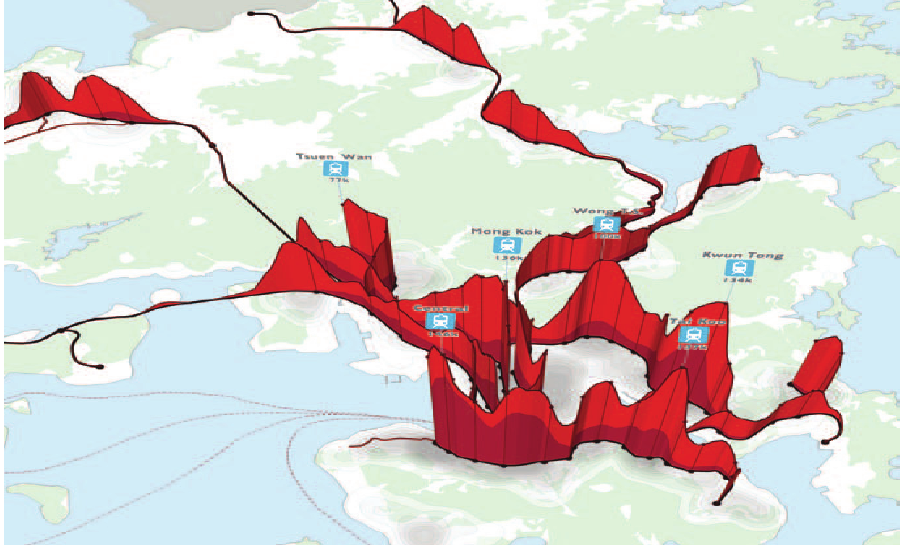
Figure 3: Population and employment density along Hong Kong’s MTR